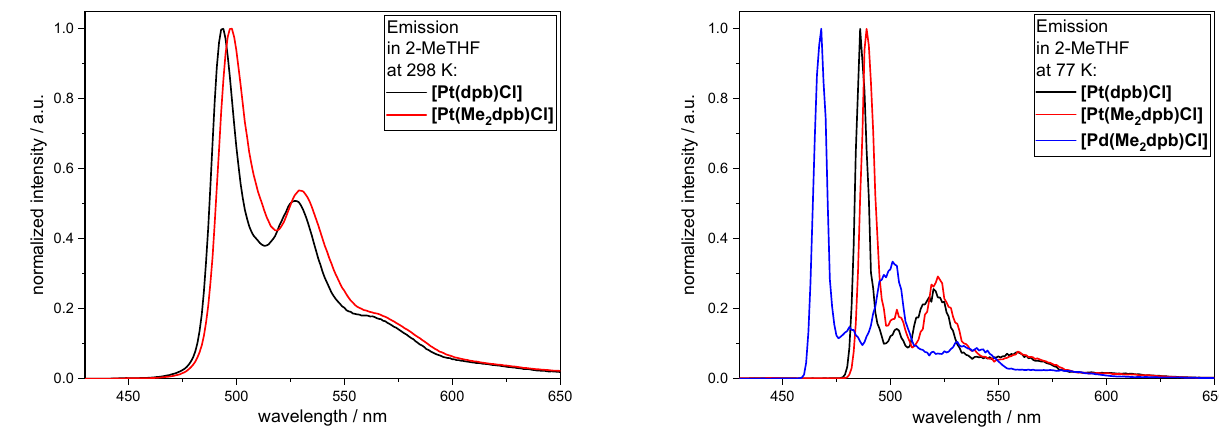
Figure 5. UV-vis absorption spectra of [Pt(Me 2 dpb)Cl] in THF/ n- Bu 4 NPF 6 , recorded during cathodic reduction ( A ) and anodic oxidation ( B ).